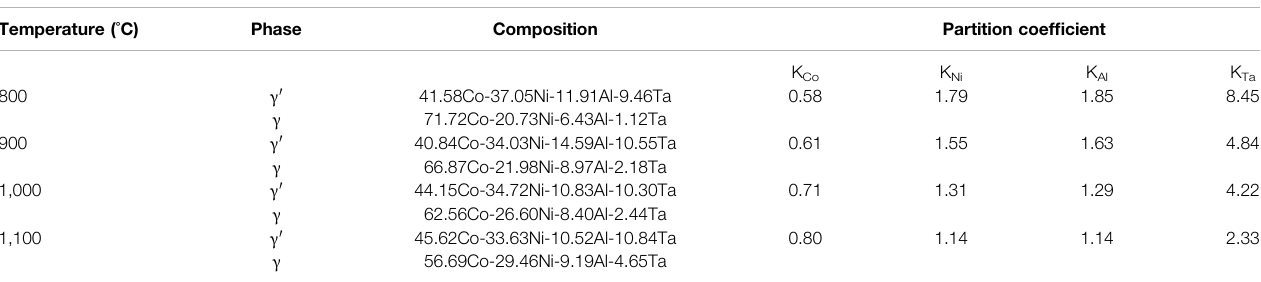
TABLE 1 | Composition of γ ’ / γ phases of alloys at various